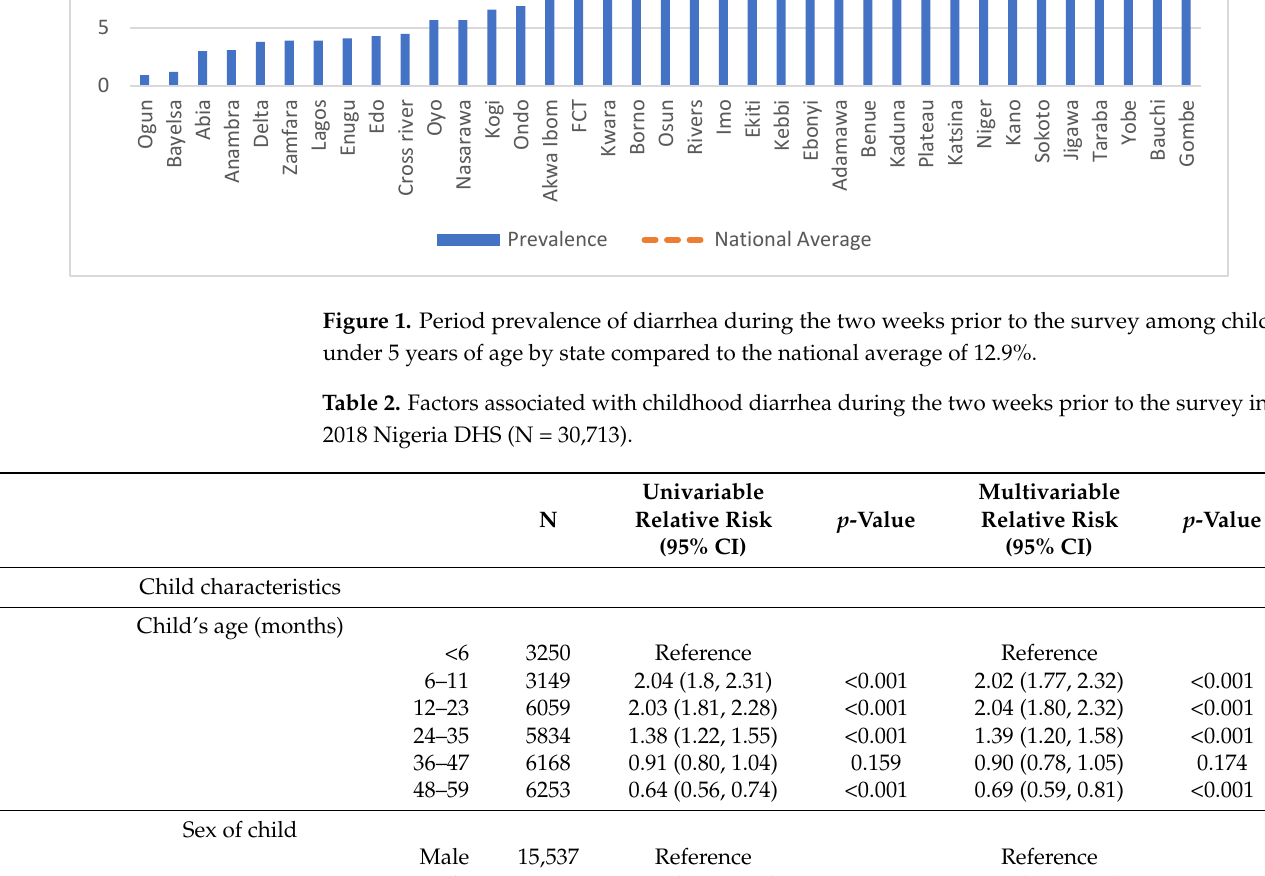
Table 2. Factors associated with childhood diarrhea during the two weeks prior to the survey in the 2018 Nigeria DHS (N = 30,713).